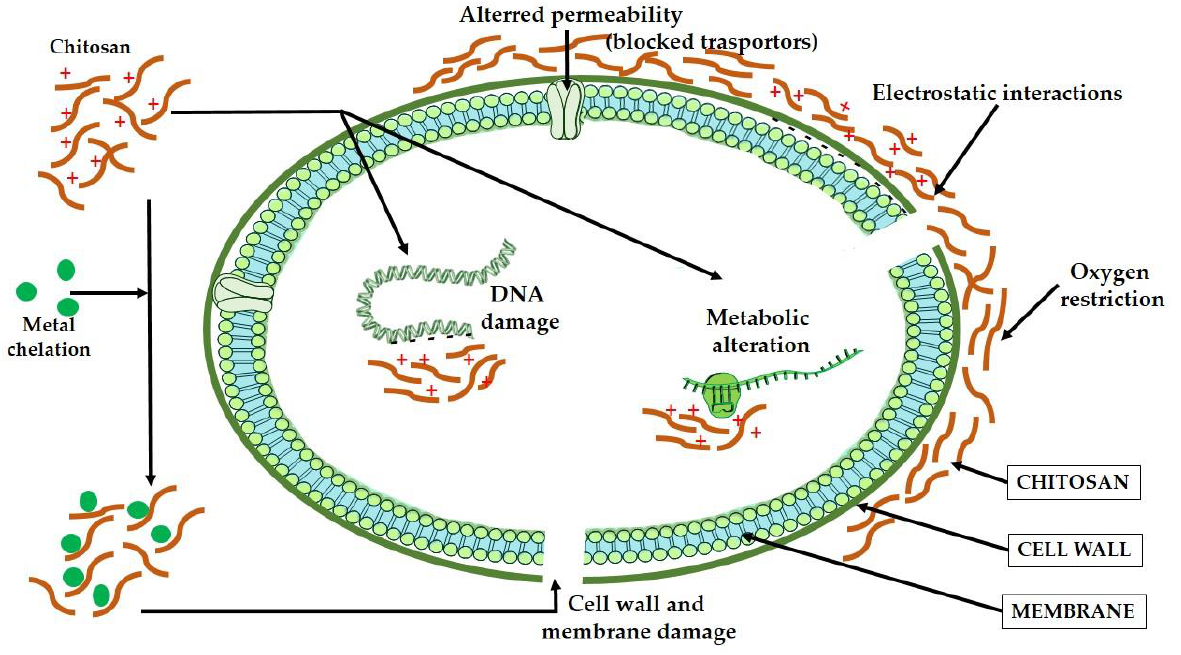
Figure 4. Antimicrobial mechanisms of chitosan-based materials.